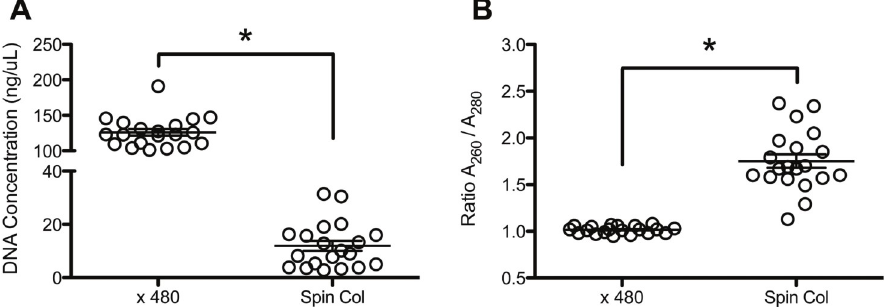
Fig 3. Comparison of DNA eluates from the cobas x 480 and spin columns. (A) Total DNA concentrations measured from x 480- and spin column-purified DNA eluates by NanoDrop spectrophotometry (absorbance at 260 nm; A 260 ). (B) Crude DNA purity from the eluates was similarly assessed and expressed as a ratio of A 260 /A 280 . Asterisks denote significant differences in DNA concentration and purity between the extraction methods as determined by the Student’s t -test (p <